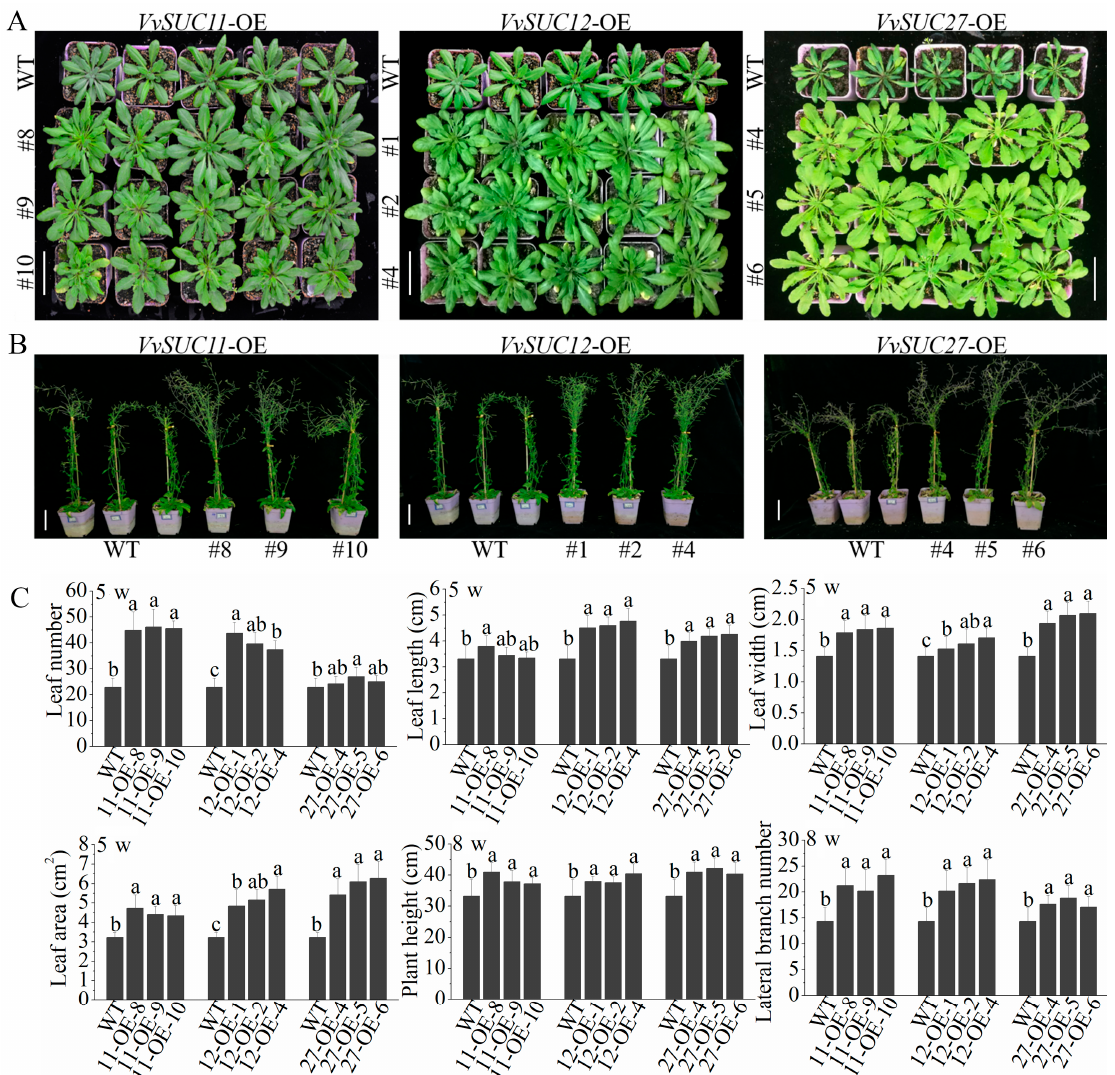
Figure 4. Phenotypes of VvSUC ‐ OE Arabidopsis grown in soil. ( A ) The phenotype differences in 5 ‐ week ‐ old VvSUC11 ‐ , VvSUC12 ‐ , and VvSUC27 ‐ OE lines, compared with those of WT. Bars = 5 cm. ( B ) The phenotype differences in 8 ‐ week ‐ old seedlings of VvSUC ‐ OE lines and WT. Bars = 5 cm. ( C ) The phenotypic differences in leaf number, leaf length, leaf width, and leaf area between 5 ‐ week ‐ old VvSUC ‐ OE lines and WT and the phenotypic differences in plant height and lateral branch number between 8 ‐ week ‐ old VvSUC ‐ OE lines and WT. Data are expressed as mean ± SD (n = 5). Different letters indicate significant differences ( P < 0.05) between each VvSUC ‐ OE line and WT as determined by ANOVA followed by Tukey’s test.